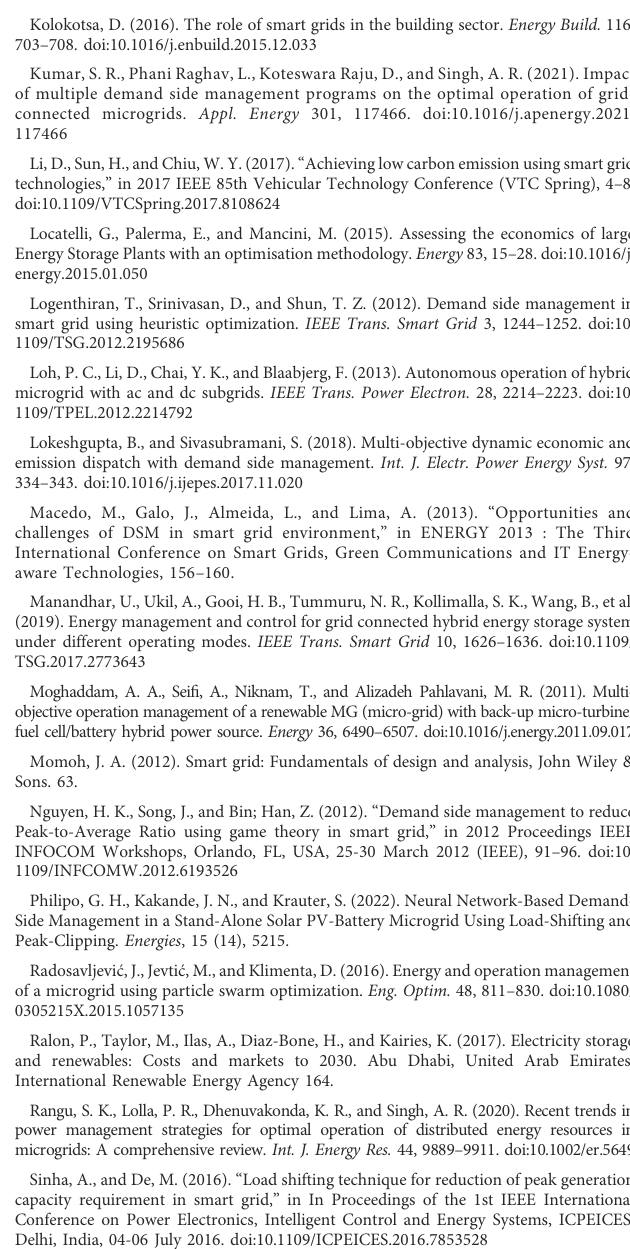
Table of Contents (2018). Nippon ronen igakkai zasshi. Japanese J. Geriatr. 55 , Contents1 – Contents1,